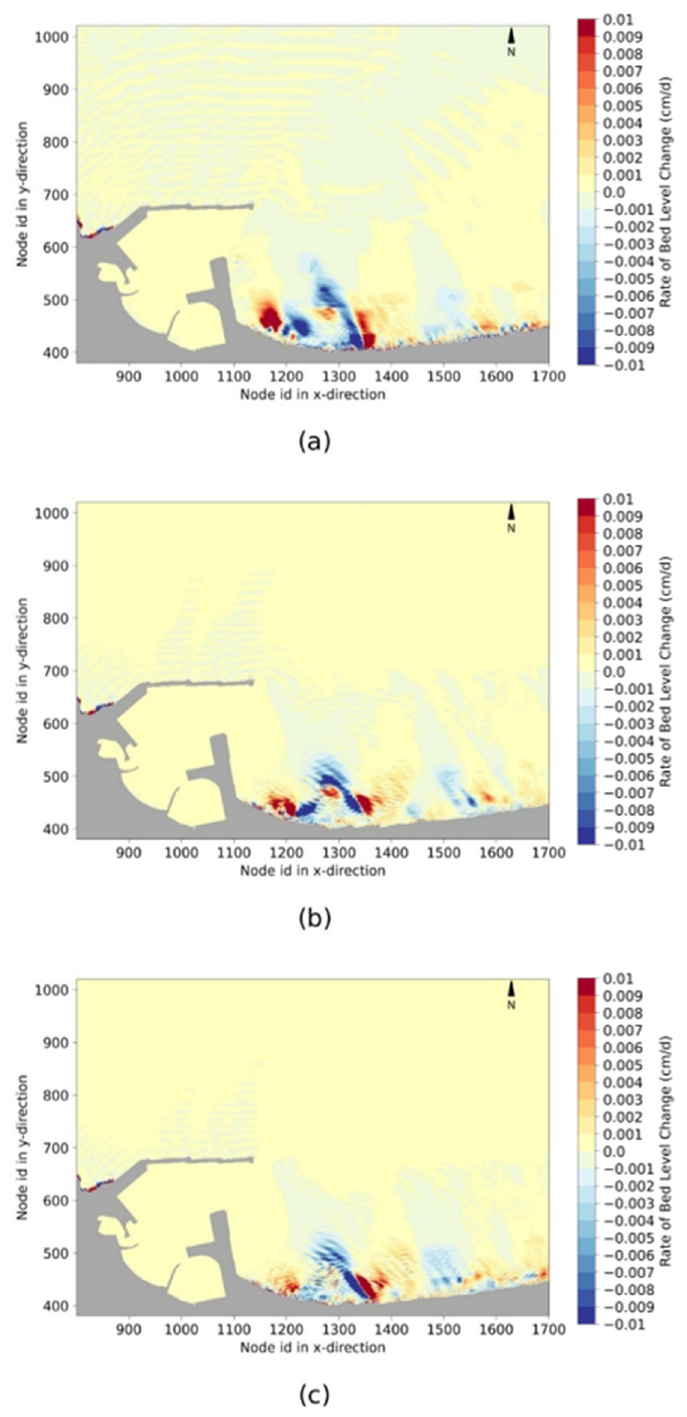
Figure 10. Integrated annual rate of bed level change for the ( a ) “BF” ( b ) “EW w/ANN”, and ( c ) “EW w/threshold” simulation sets.